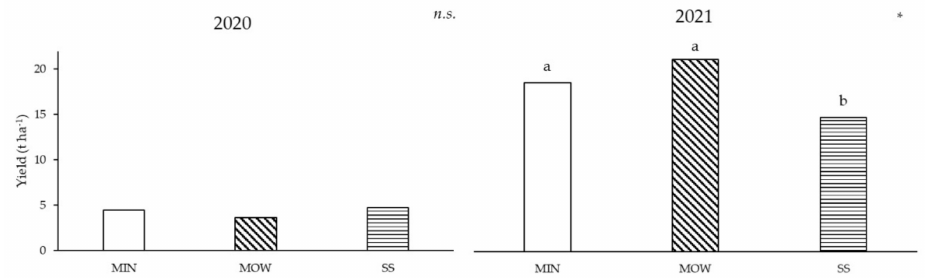
Figure 5. Effect of fertilization treatment on yield in 2020 and 2021. MIN: mineral; MOW: municipal organic waste compost; SS: sewage sludge compost. ns , *: effect not significant or significant at p ≤ 0.05, respectively. Means followed by the same letter are not statistically different ( p ≤